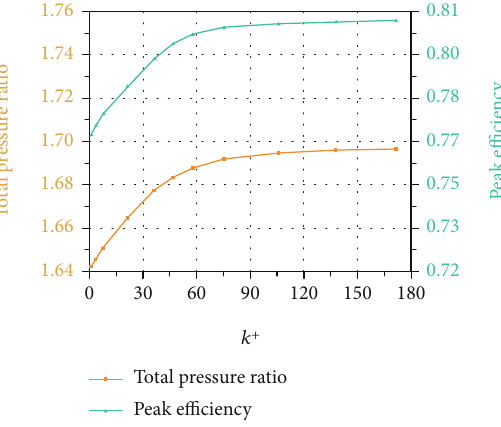
Figure 7: Variations of the aerodynamic performance parameter with increasing k +